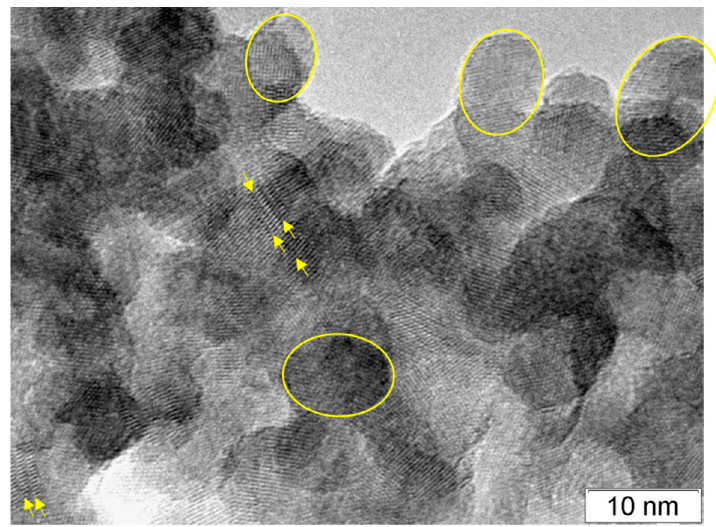
Figure 8. TEM image of Cd 0.7 Mn 0.3 S nanoparticles (HTS at T = 100 °C). The yellow ellipses show particle shape, and the yellow arrows show SFs.